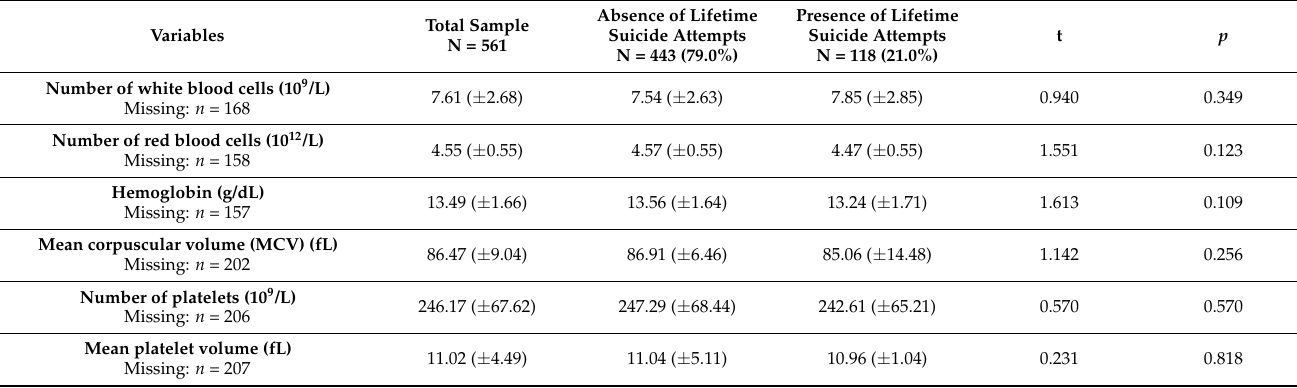
Table 3. Biochemical parameters of the total sample and of the two groups obtained according to the presence of lifetime suicide